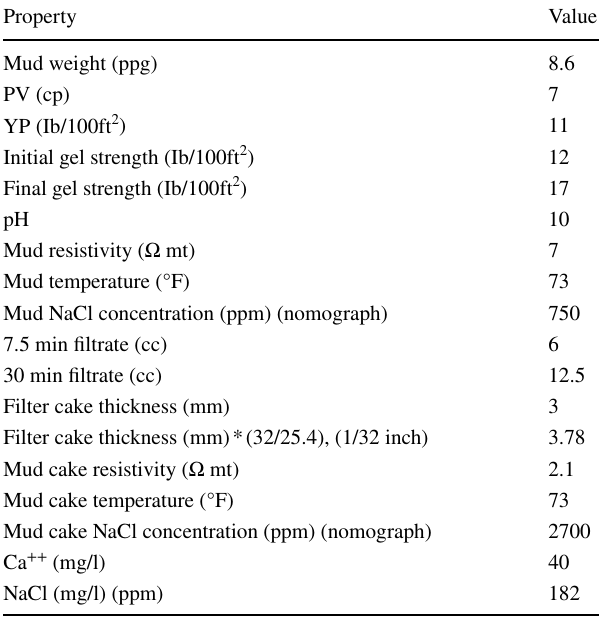
Table 1 Reference fluid (RF) sample properties